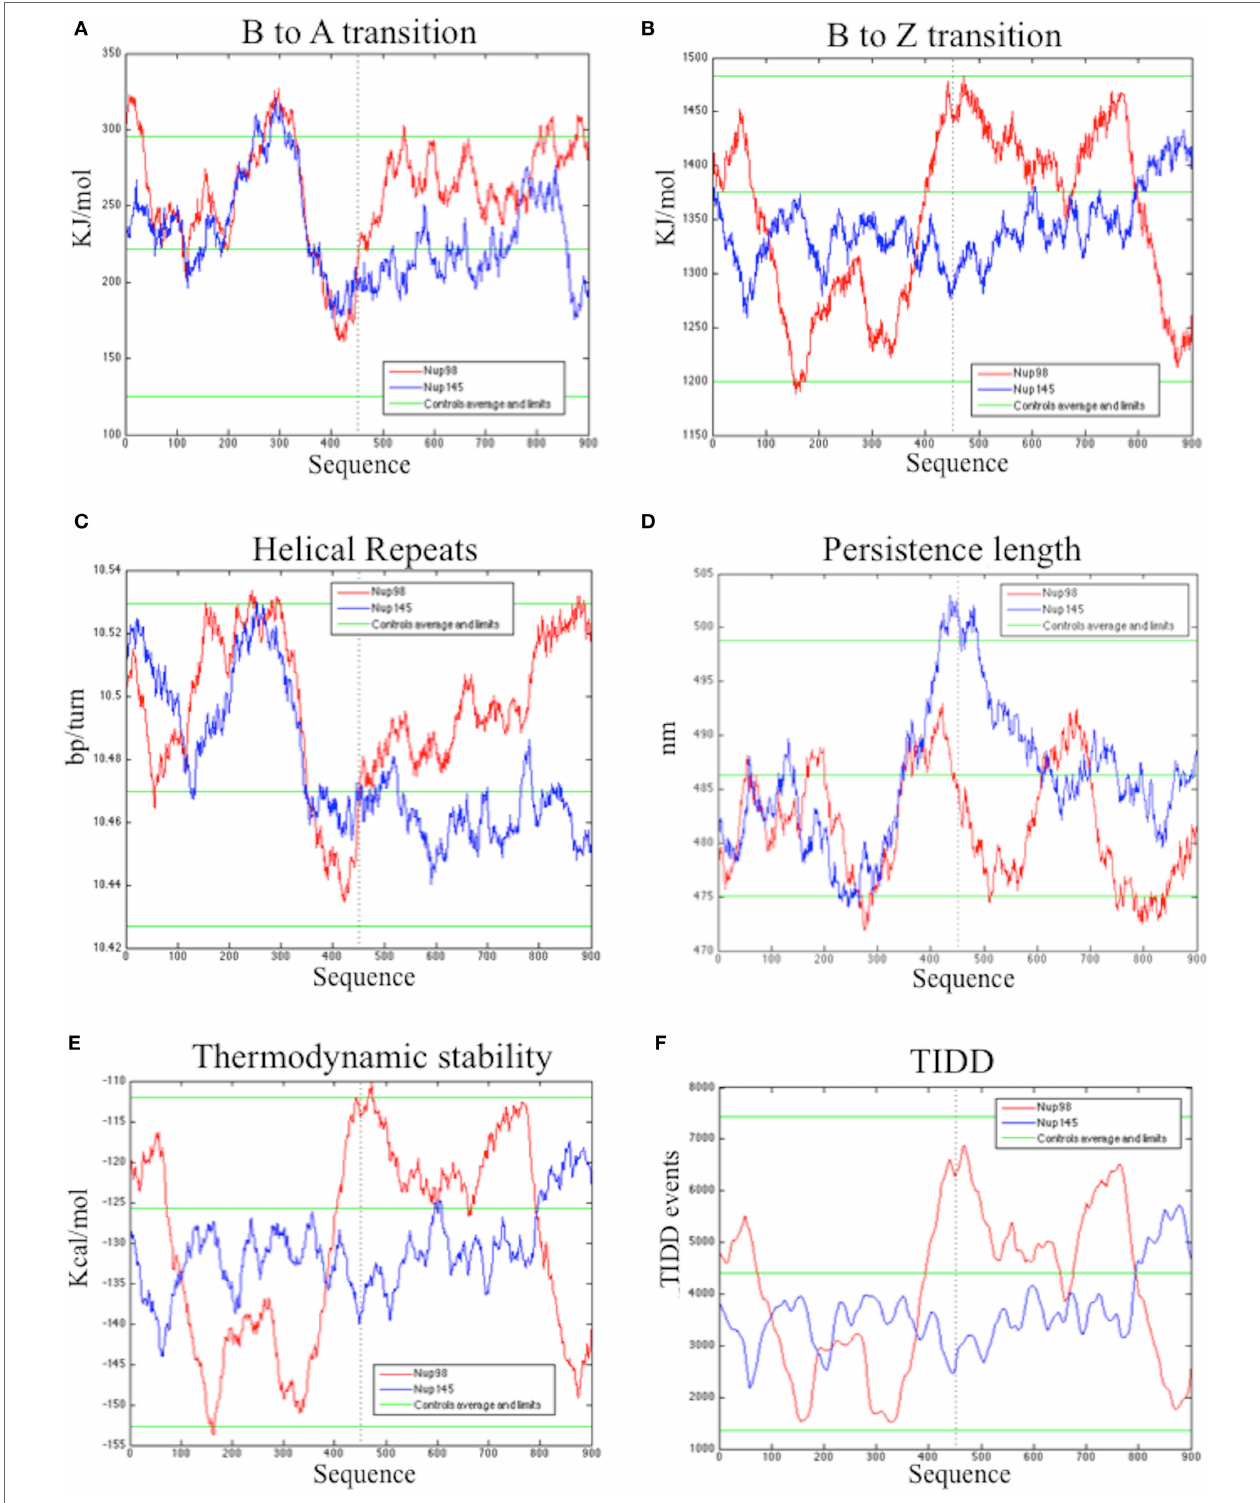
FigUre 6 | Bioinformatic analysis of the physicochemical and conformational properties of the sequences around the breakpoints of NUP98 (red color) and NUP145 loci (blue color). The three green lines in each graphic correspond to an average, maximum and minimum value of five control sequences (see Materials and Methods for details). (a) B to A transition, (B) B to Z transition, (c) Helical repeats, (D) Persistence length, (e) Thermodynamic stability, (F) thermally induced duplex destabilization (TIDD). The X -axis is labeled with numbers representing the nucleotide sequence; the Y -axis is labeled, in the different panels, with kiloJoule per mole (kJ/mol), nanometers (nm), kilocalories per mole (kcal/mol), base pairs per helical turn (bp/turn).